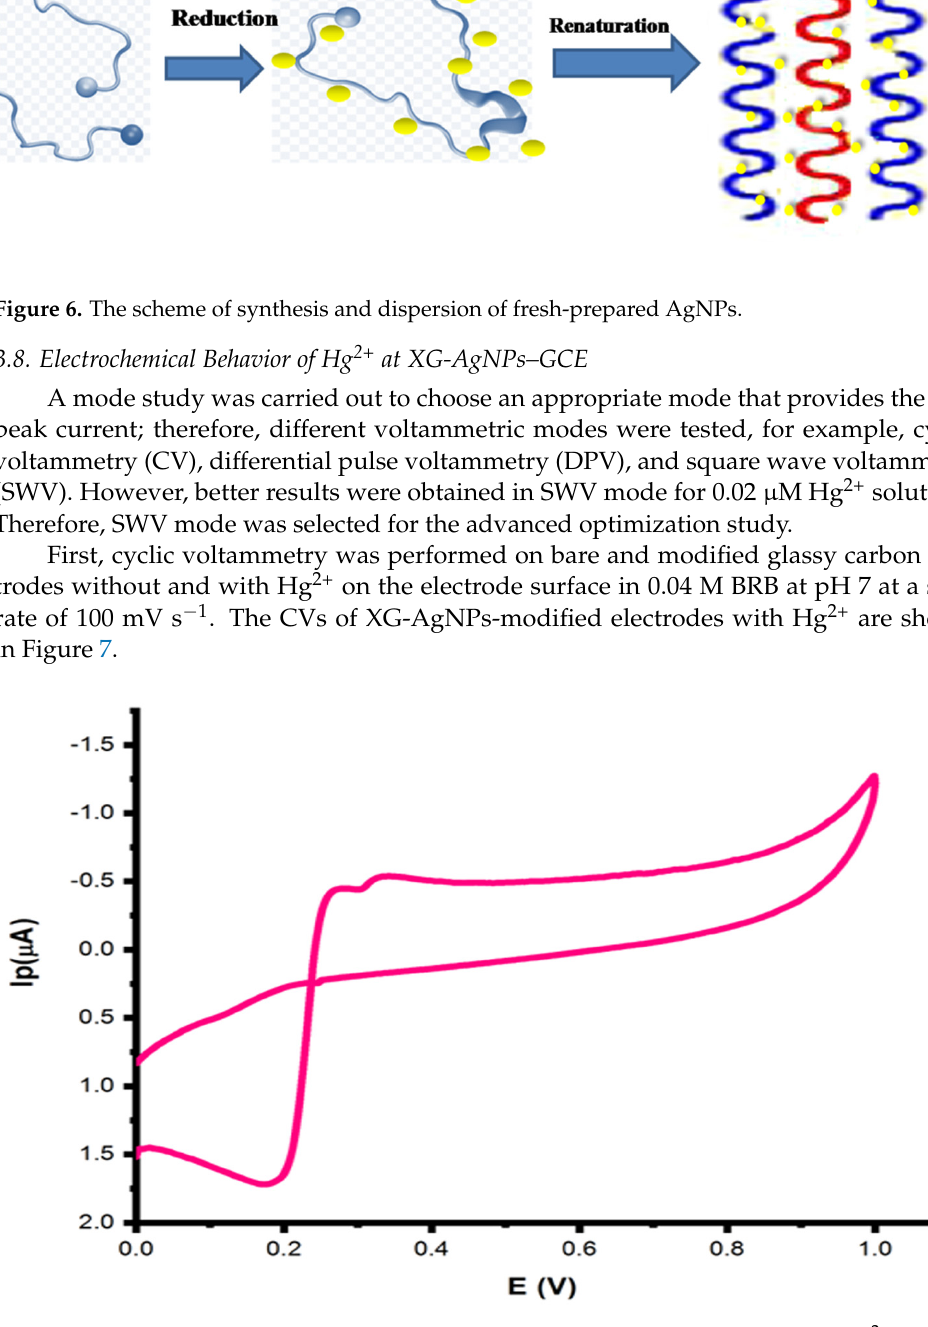
Figure 7. Cyclic voltammogram of modified xanthan gum nanoparticle electrode for Hg 2+ ions.